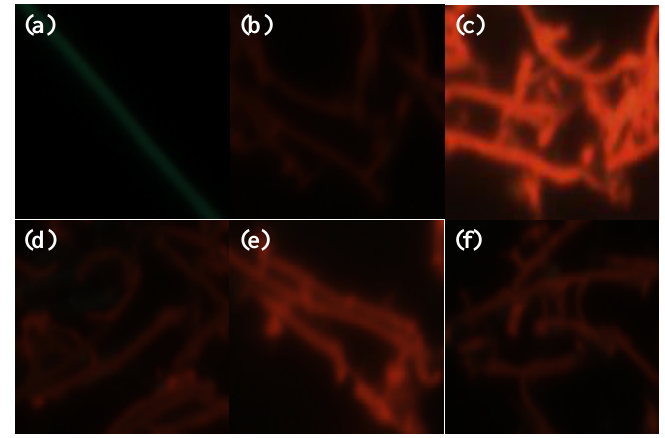
Figure 5. CCD images of ( a ) pristine P3MT, ( b ) P3MT/pDNA (30 pair), ( c ) P3MT/pDNA-tDNA (30–30 pairs), ( d ) PBS buffer treated P3MT/pDNA (30 pair), ( e ) 1-mer mismatched tDNA treated P3MT/pDNA (30 pair) and ( f ) thrombin protein treated P3MT/pDNA (30 pair), respectively.